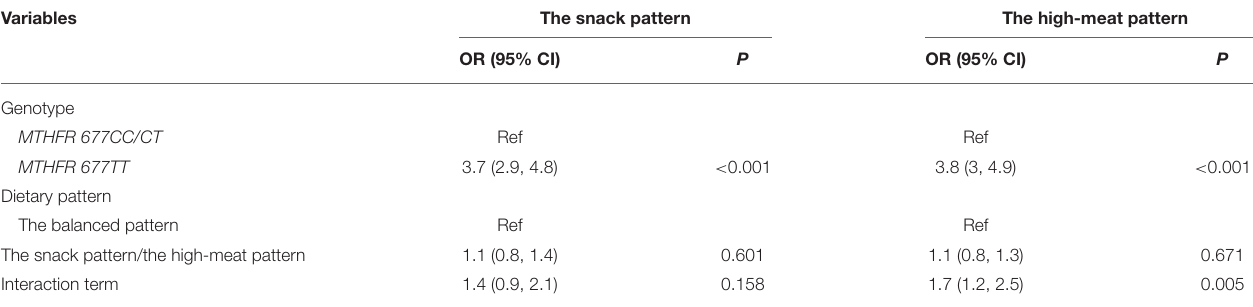
TABLE 3 | Interaction between dietary patterns and MTHFR C677T genotypes in relation to the incidence of hyperhomocysteinemia in the multiplicative model. Variables